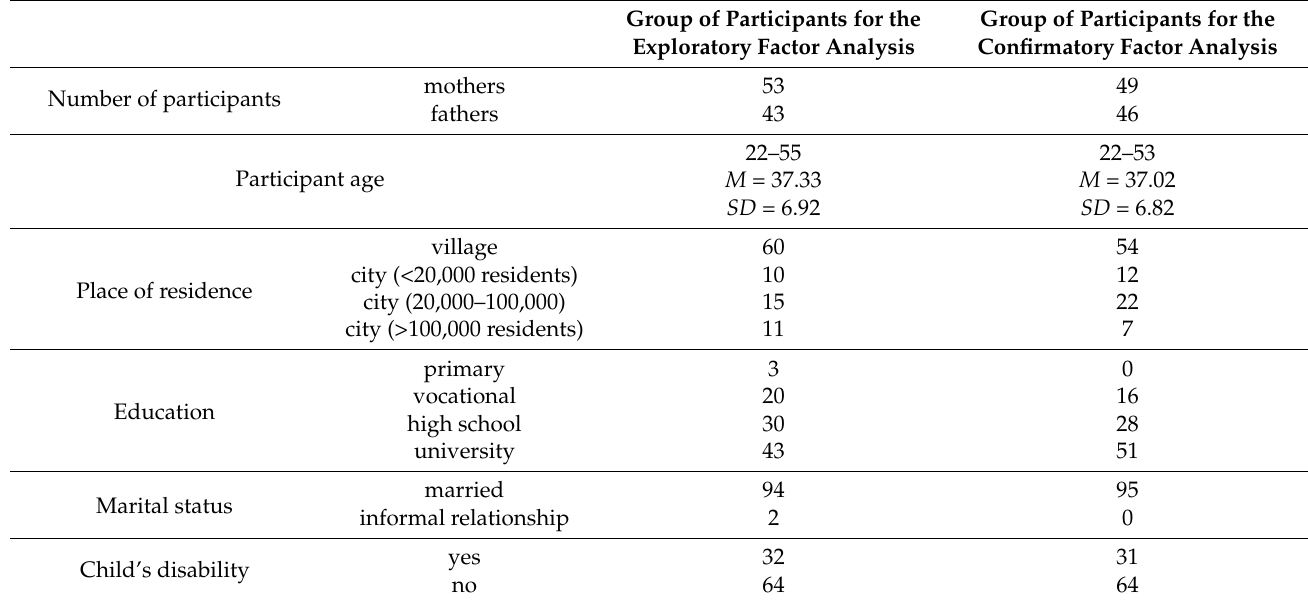
Table 2. Comparison of the participants for the exploratory ( n = 96) and for the confirmatory factor analysis ( n = 95).